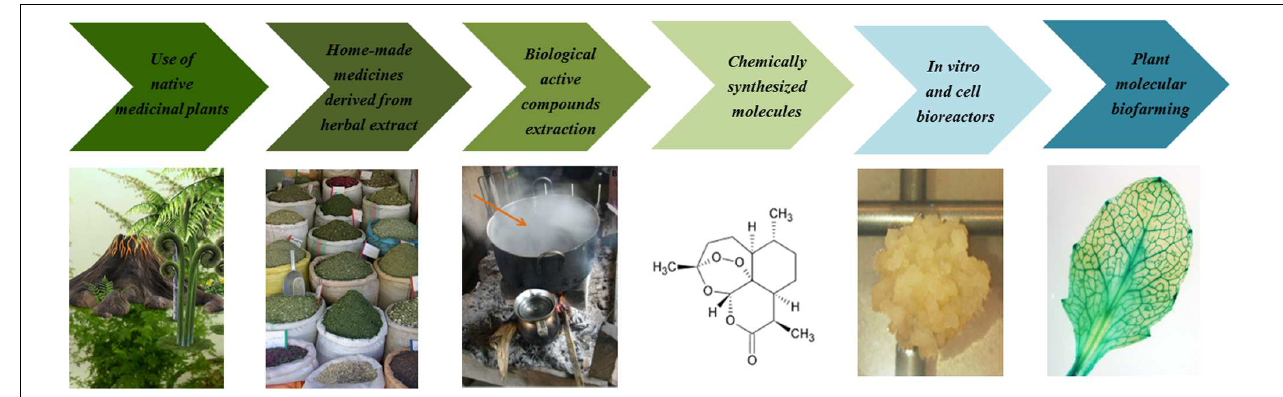
FIGURE 2 | Pharmacopoeia evolution across time. In recent centuries, pharmacopeia has developed from traditional medicine toward into plant biofarming, which integrates the use of traditional medicine with modern medicine; therefore becoming an effective and sustainable approach for improving the well-being and health of a community. Since the use of native medicinal plants and home-made herbal extracts, derived from ethno-botanical local plants, pharmacopeia has moved toward the extraction of useful essential oils and other active compounds with healing properties. Finally, plant molecular pharming has been proposed as a real alternative to chemically synthesized molecules and microbial and mammalian cell